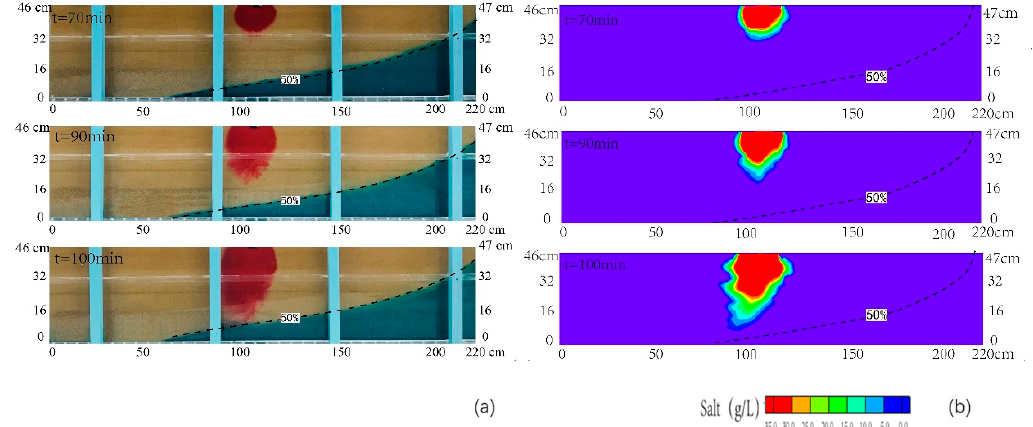
Figure 3. Observed ( a ) and simulated ( b ) contamination concentration distributions in the cross section for scenario 1. The black dashed line denoted the contour line with the concentration of 0.5 time of seawater concentration.